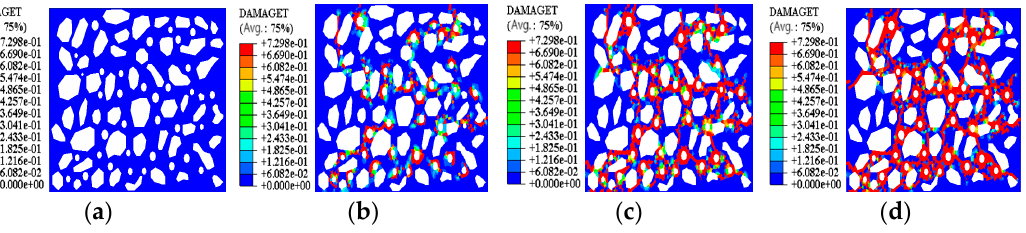
Figure 9. Damage nephogram of model 1 at different stages. ( a ) Step Time = 0; ( b ) Step Time = 0.37; ( c ) Step Time = 0.52; ( d ) Step Time = 1.